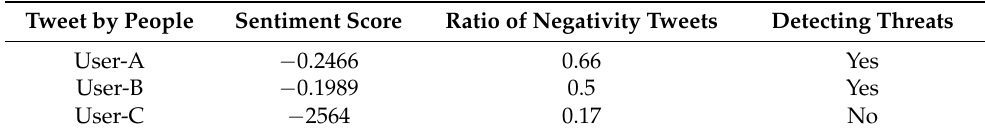
Table 8. Sample of detecting